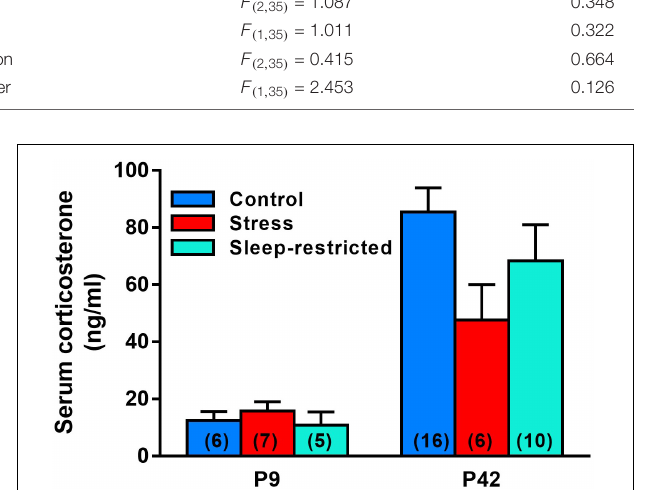
FIGURE 2 | Serum corticosterone concentrations at P9 and P42 after control, stress, and sleep-restriction commencing at P5. Bars represent mean ± SEM for the number of mice indicated on the figure. Results of ANOVA are given in Table 2 .